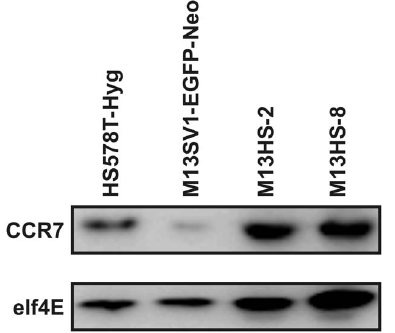
Figure 1. CCR7 expression of parental cell lines and hybrid cell lines. CCR7 expression was detected by Western Blot analysis, whereby elf4E expression was used as an internal control. Shown are representative Western Blot data of n=3 independent experiments.